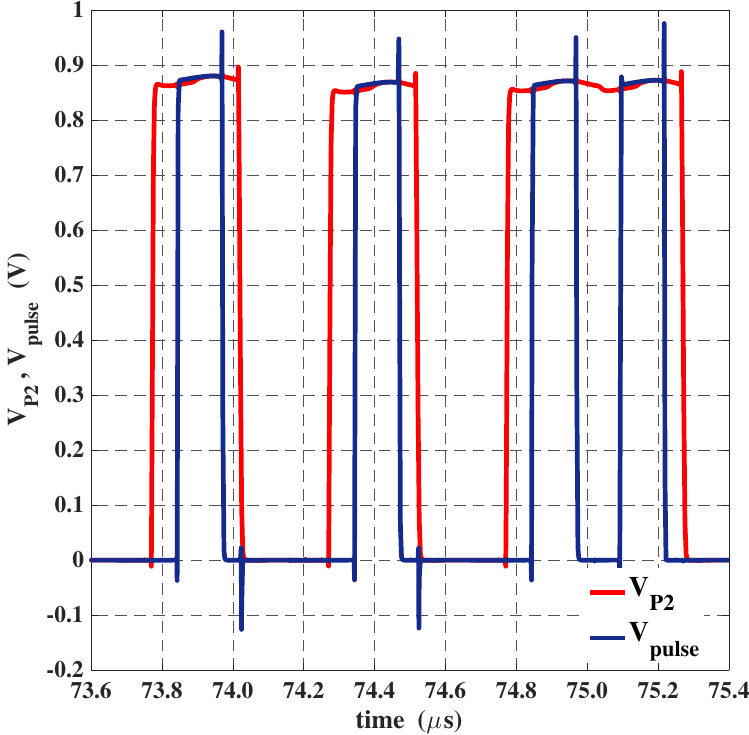
Figure 11. Transient simulation of signals V P 2 and V pulse . At time instant t = 75 µ s the phase modulation starts.